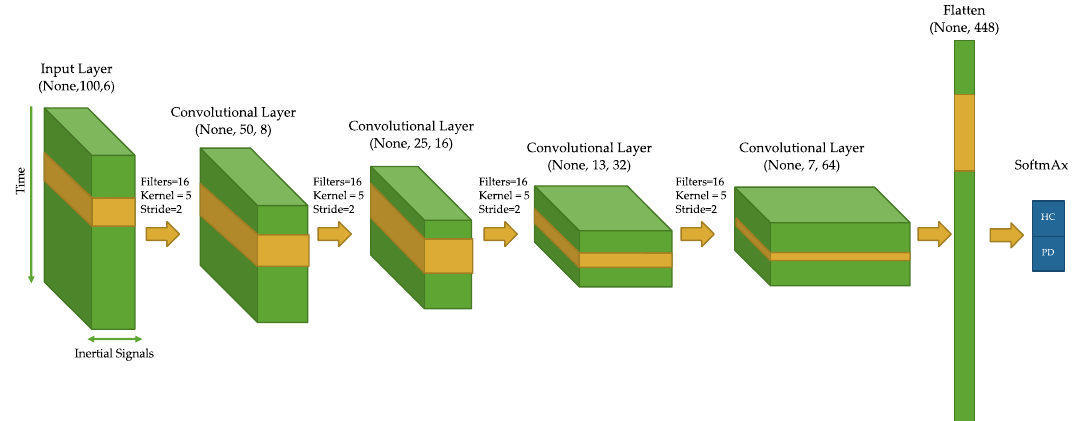
Figure 2. Architecture of the one-dimensional convolutional neural networks classifier for PD detection using 6-channel inertial data from walk-like events.